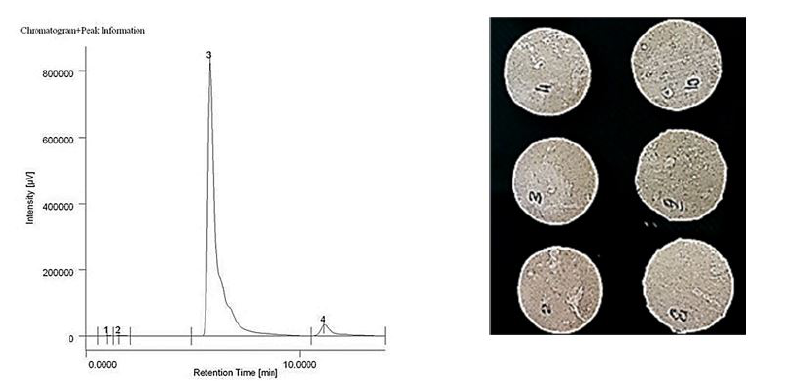
Figure 1. The calibration curve of standard MMA and samples of toxicity for